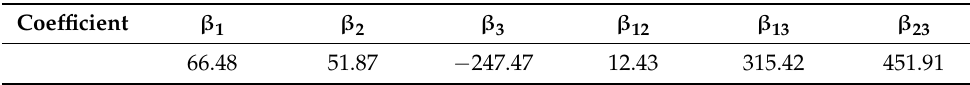
Table 5. Scheff é quadratic model